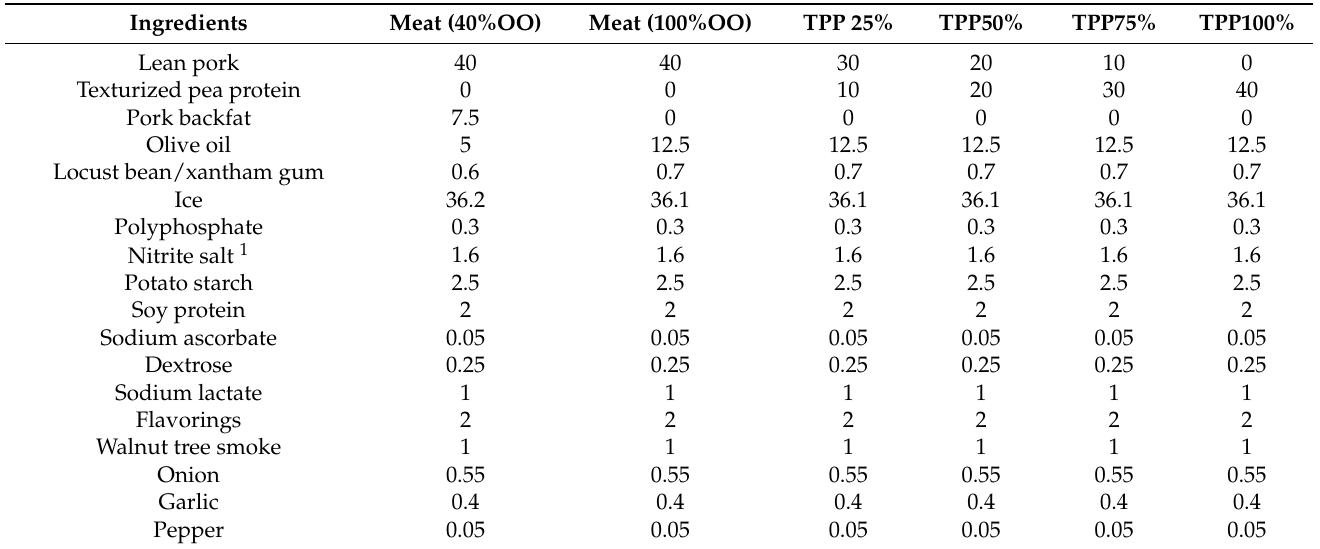
Table 1. Low-fat frankfurter formulations with backfat replacement with olive oil and different levels of replacement of meat by texturized pea protein as a percentage of total